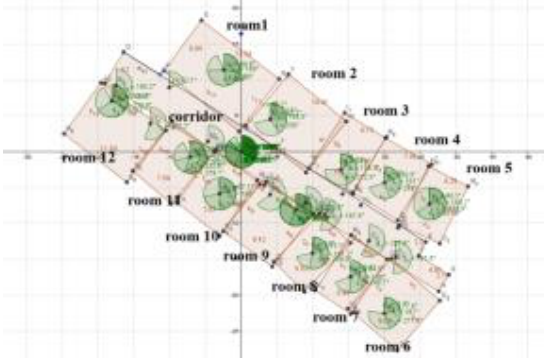
Figure 5: Floor plan by Trimble LaserAce 1000.